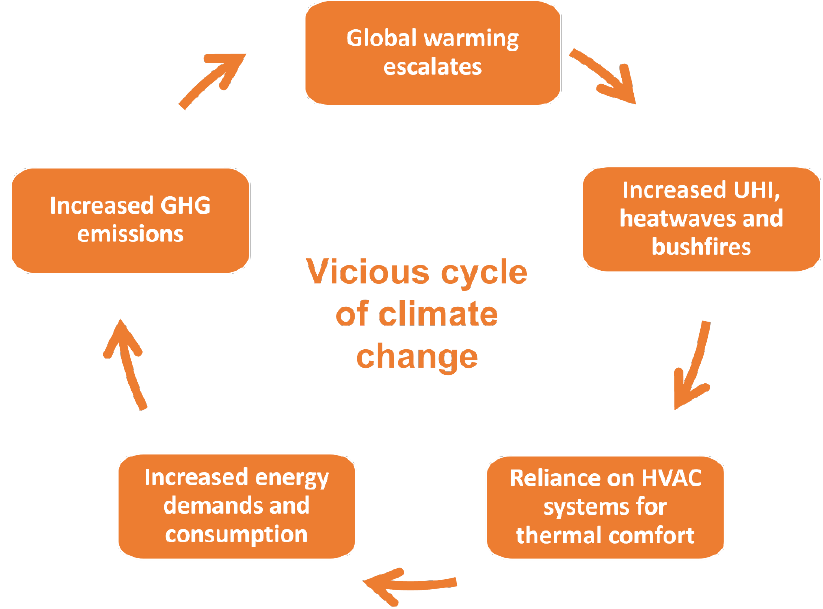
Figure 1. The vicious cycle of climate change.